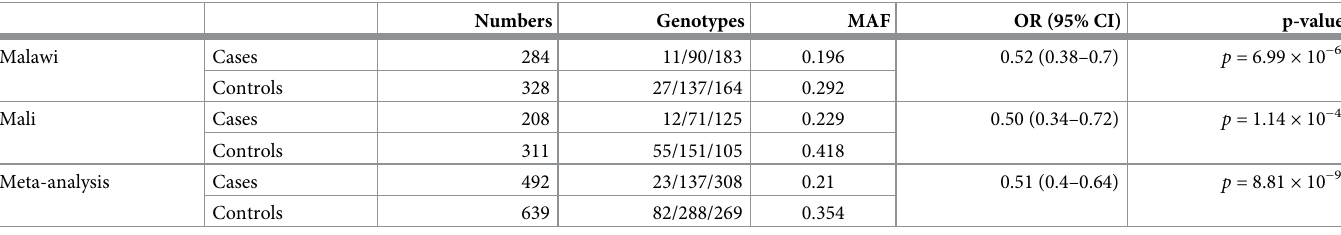
Table 2. Effect of rs2015583 genotype on risk of leprosy in Malawi &